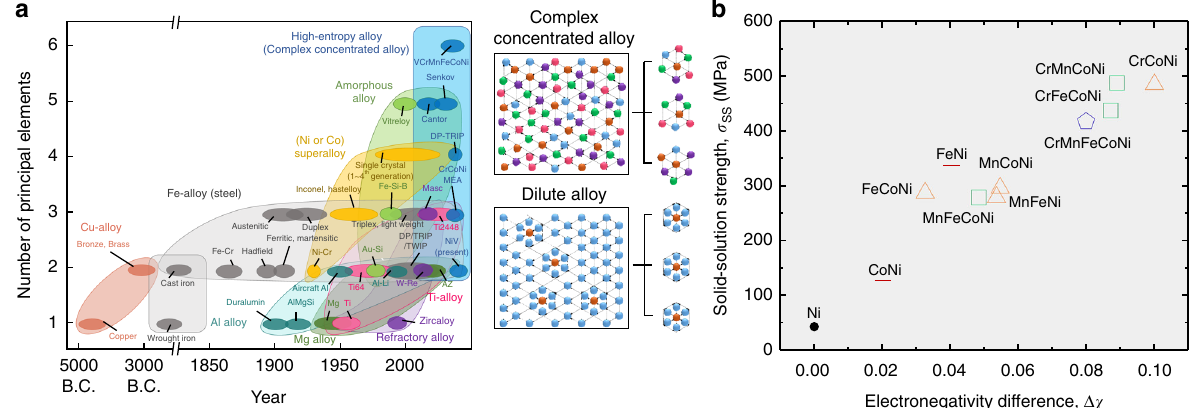
Fig. 1 Proportional relationship between electronegativity difference and solid-solution strength in complex concentrated and high-entropy alloys. a A historical sketch showing an upward trend in the number of principal elements ( ≥ 5 at.%) constituting general alloy systems over the past centuries. It includes Cu-, Fe-, Al-, Mg-, Ti-, and refractory alloys as well as superalloys (Ni-based or Co-based), amorphous and high-entropy alloys. b Electronegativity differences among the constituting elements Δ χ versus experimentally measured solid-solution strengths σ SS of 3d CCAs 25 for solid-solution strengthening relation. The experimentally measured solid-solution strengths are listed in Supplementary Table